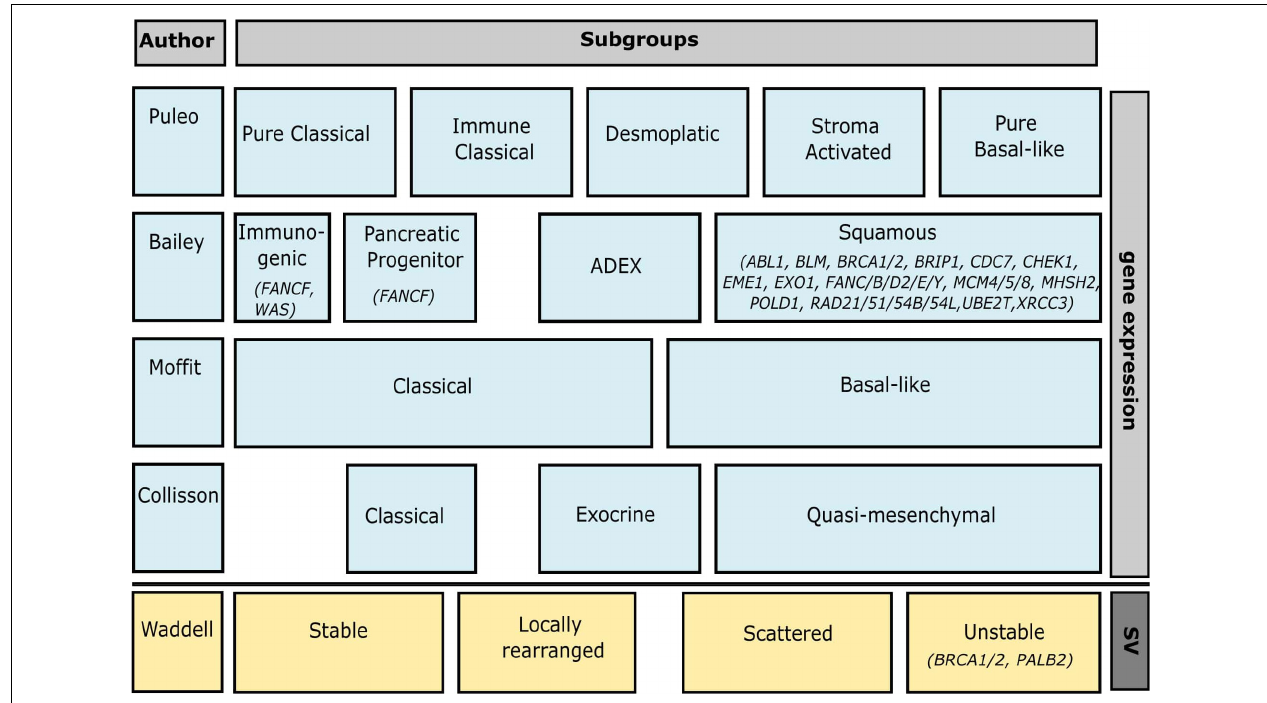
FIGURE 2 | Overview of genomic pancreatic subtypes and how they overlap. Associated DDR genes of which mutations have been found in PDAC patients (see Supplementary Table 1 ) are included under their respective subtypes. The bar on the right indicates whether the classification is based on gene expression or structural variation (SV). Associated DDR genes not mutated in patients include CDC45 , FEN1 , GINS2/4 , MAD2L2 , MCM2/3/6/7 , RMI2 , RPA3 , TIMELESS , HMGB2 , POLA1 , LIG1 , DNA2 , RDC2/3/4/5 , PCNA , COPS5 , BRIP1 , HMGA2M , CETN2 , UBC , TP73 , PSMD14 , POLR2D , and CDK7 for Bailey’s squamous subtype, and USP7 for Bailey’s Pancreatic Progenitor subtype. This figure was created in